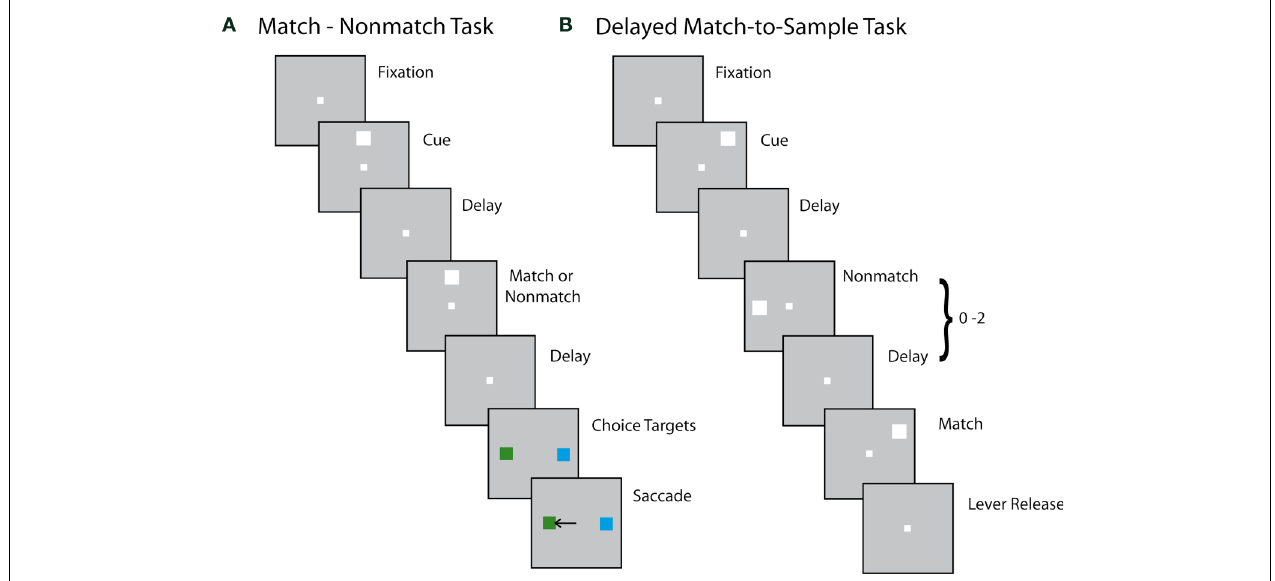
FIGURE 2 | Behavioral tasks. Successive frames indicate the series of stimulus presentations. (A) Stimulus presentations in the Match/Nonmatch task. (B) Stimulus presentations in the Delayed Match-to-Sample